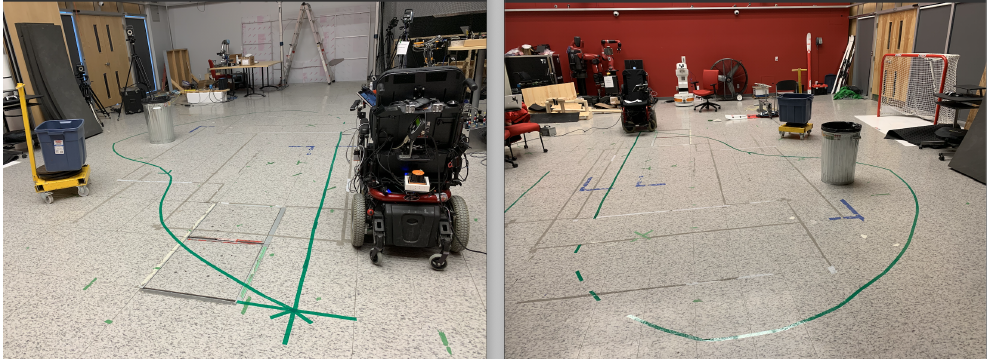
Figure 3. The predefined path marked by green tape on the floor of an experimental room of the 3IT at Université de